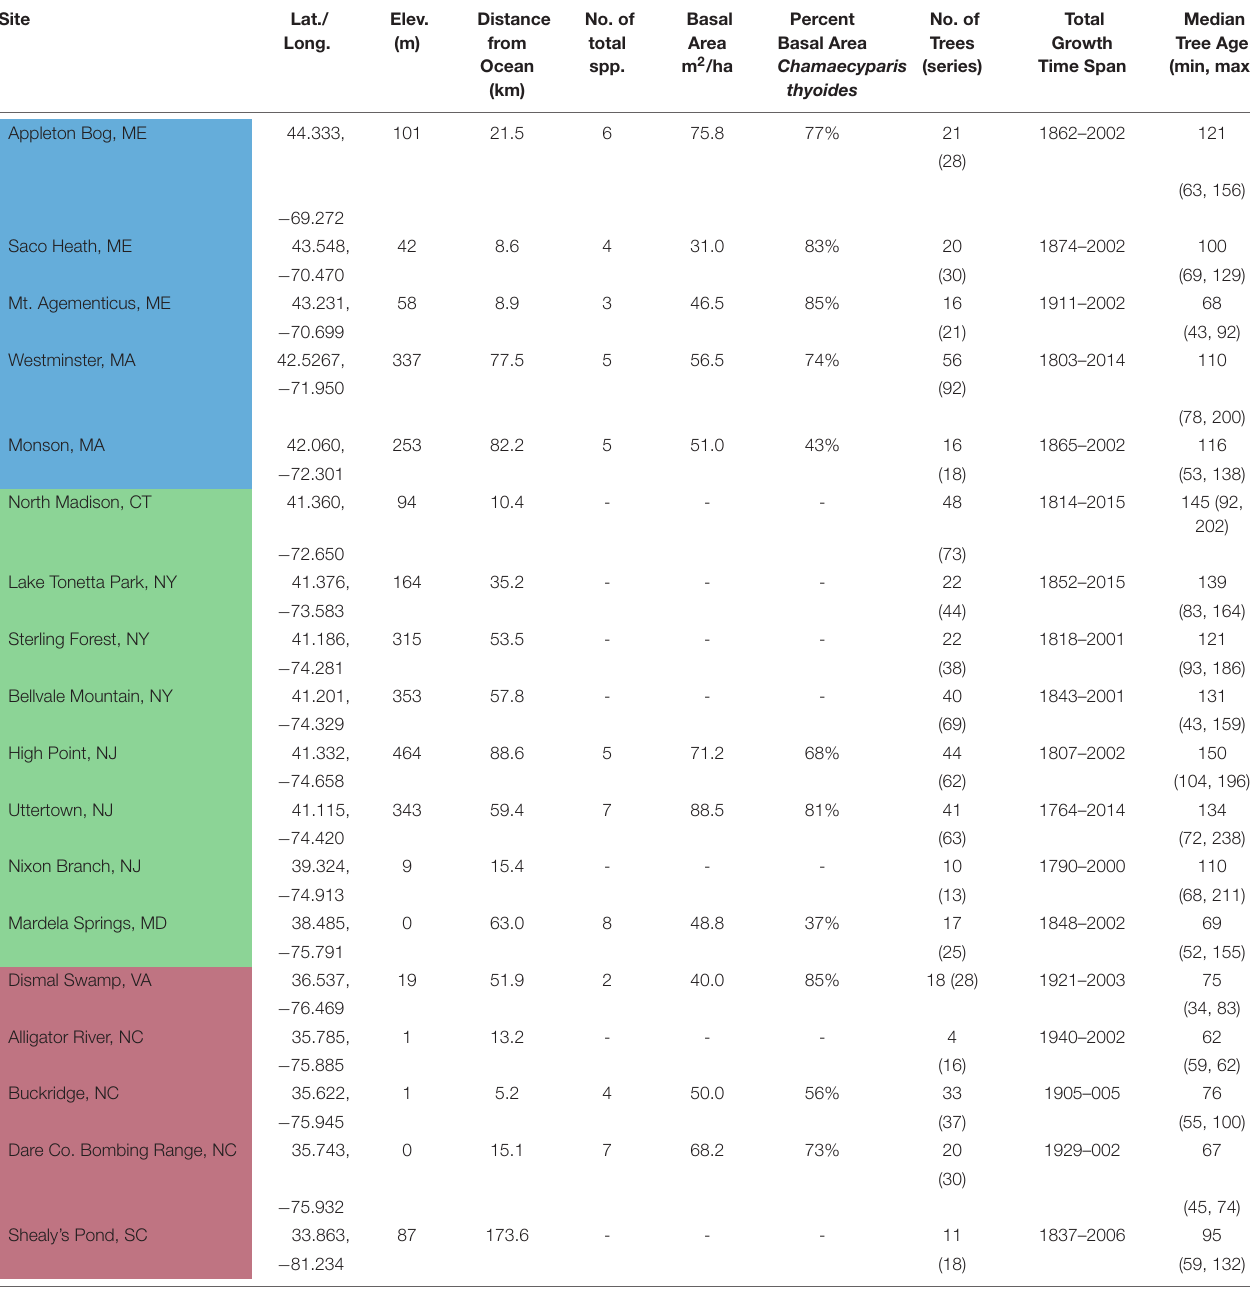
TABLE 1 | Location, site information, composition, structure, and sample replication of 18 Chamaecyparis thyoides populations for this study, arranged from highest to lowest latitudes. Site Lat./